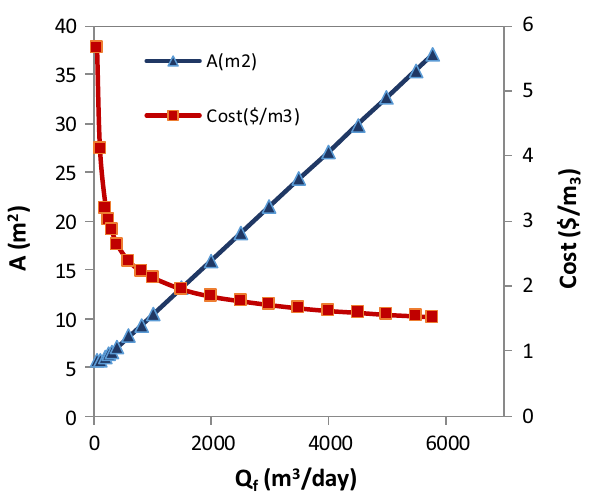
Fig. 3 Modeling feed water flow rate variations on the amount of water cost and the active area of the membrane